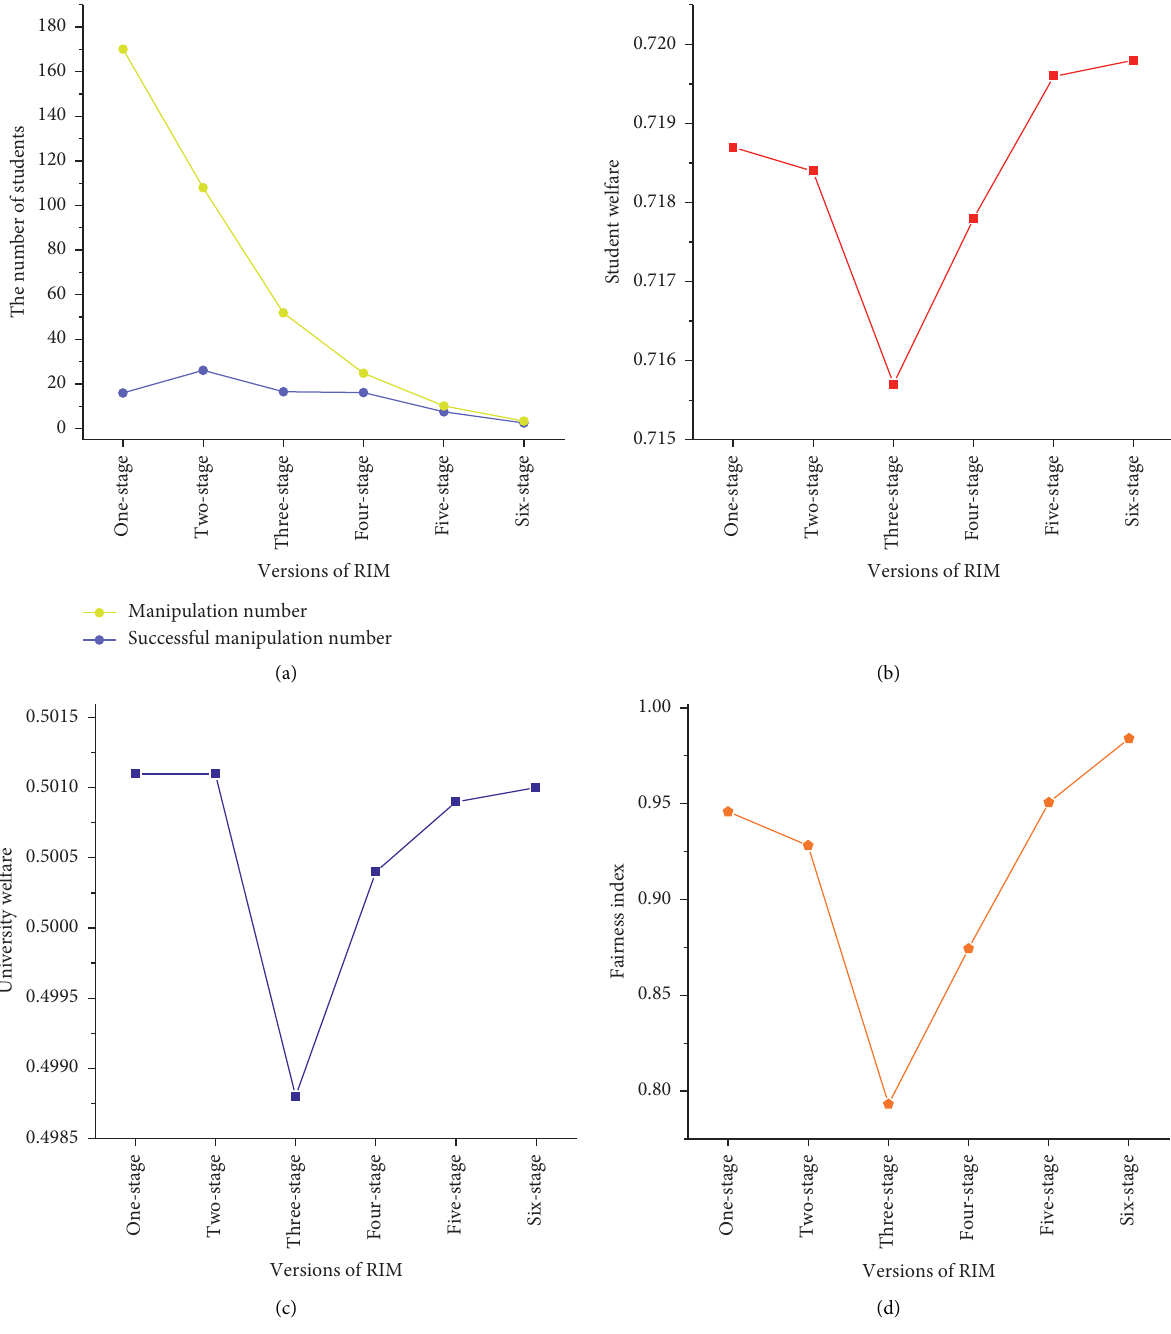
Figure 7: Simulation results under different versions of